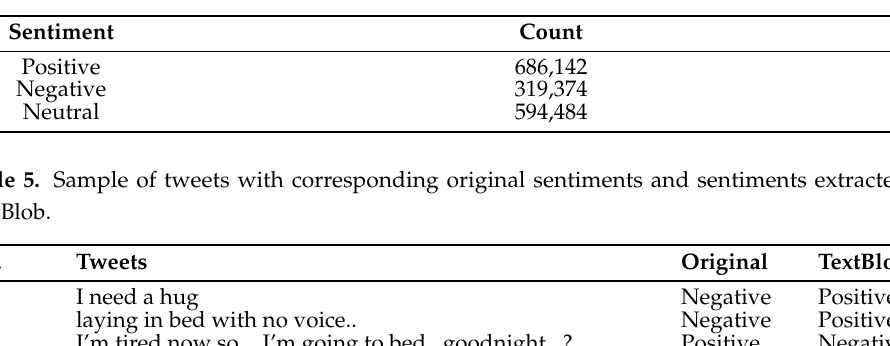
Table 4. TextBlob sentiment ratio.